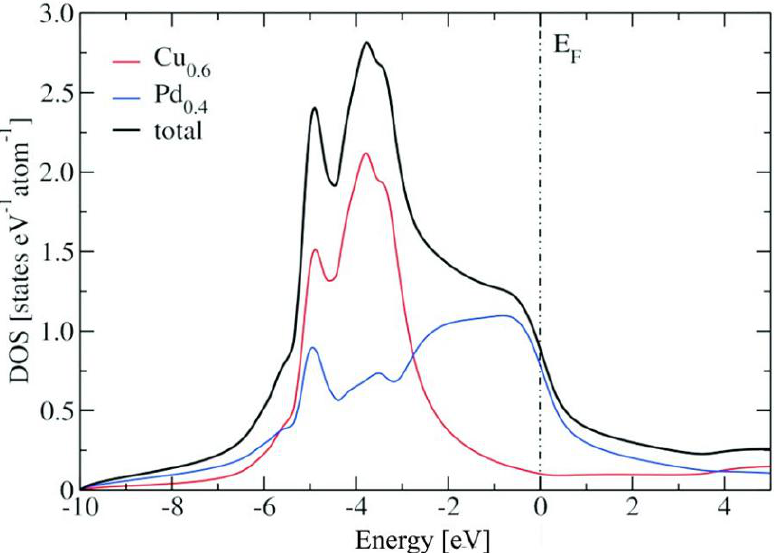
Figure 5. Total density of states (DOS) of the disordered Cu (E ) set to zero). Partial atomic contributions are F